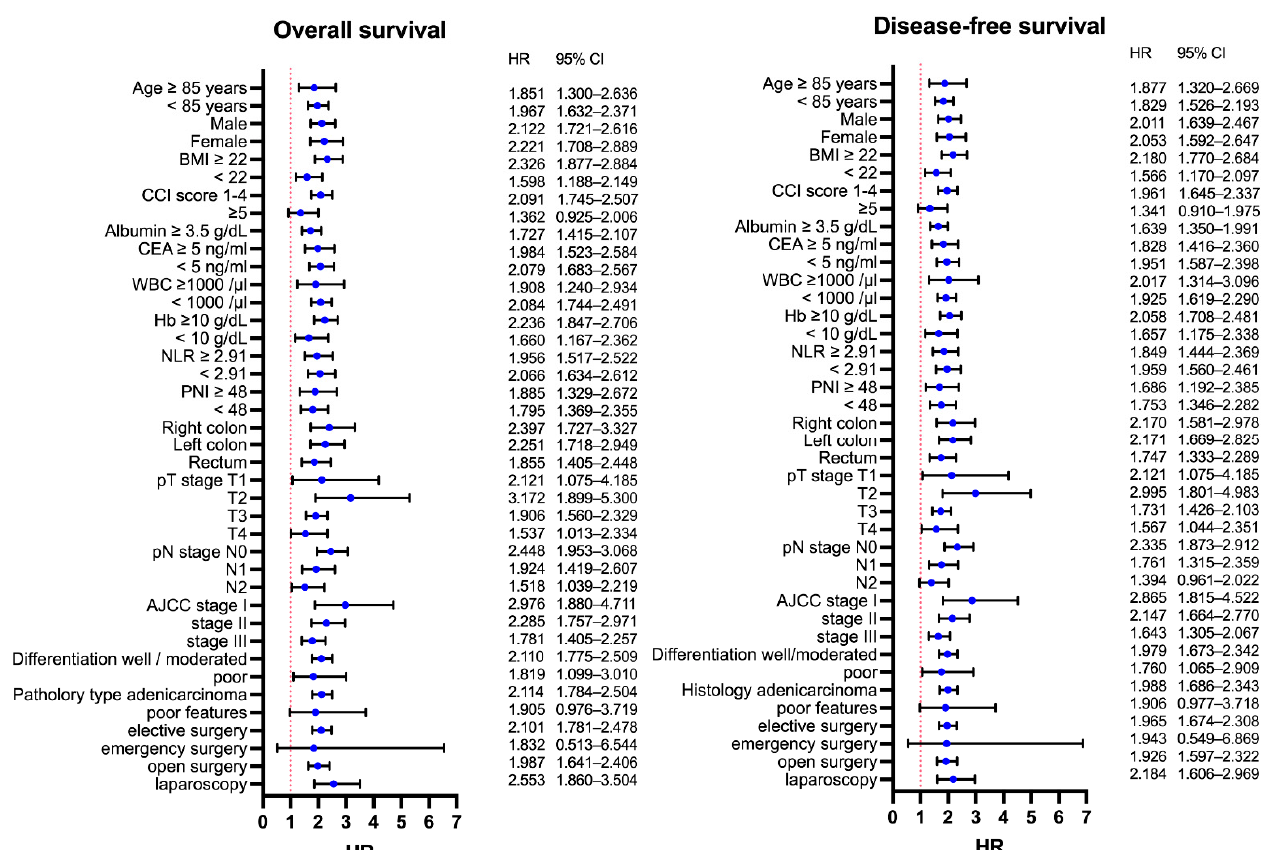
Figure 7. Summary of the subgroup survival analysis according to GNRI in each clinicopathological subgroup.